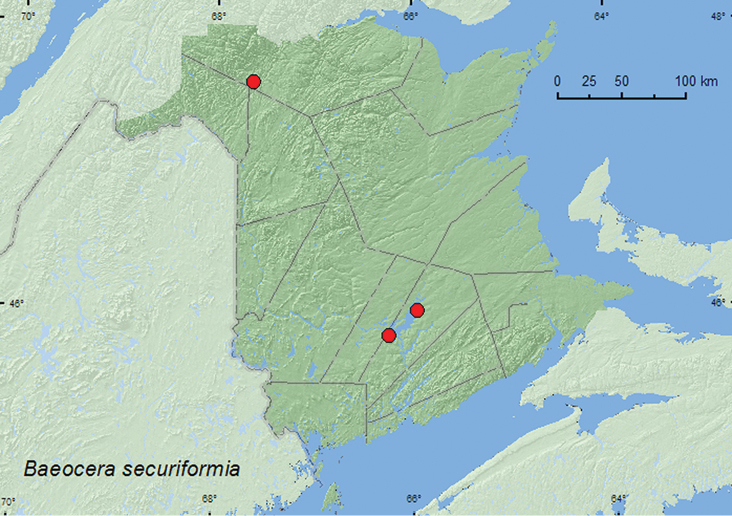
Collection localities in New Brunswick, Canada of Baeocera securiforma.